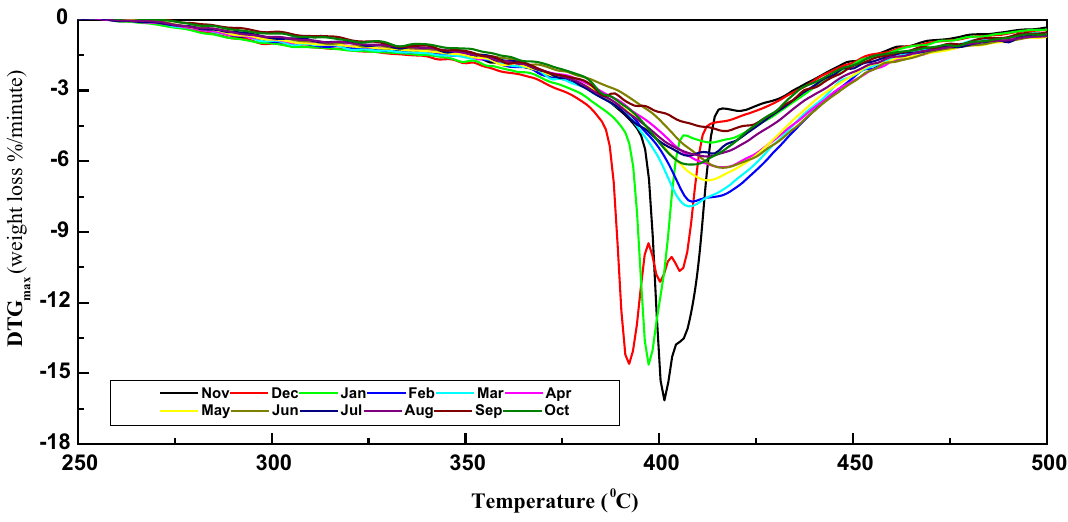
Fig. 7 DTG curves of coal with seasonal months Table 1 Month by month variation of burning temperatures and peak combustion rates Month T i ( (cid:3) C) T p ( (cid:3) C) T f ( (cid:3) C) DTG max